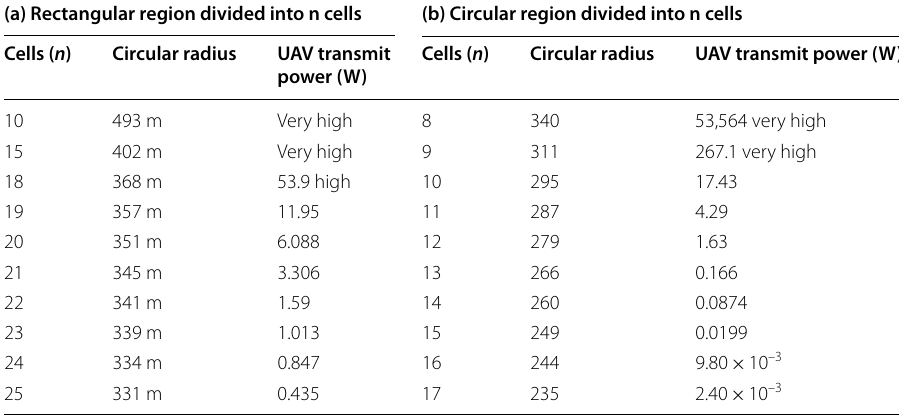
Table 1 P T requirement to cover active users in each circle cell [31] (a) Rectangular region divided into n cells (b) Circular region divided into n cells Cells ( n )